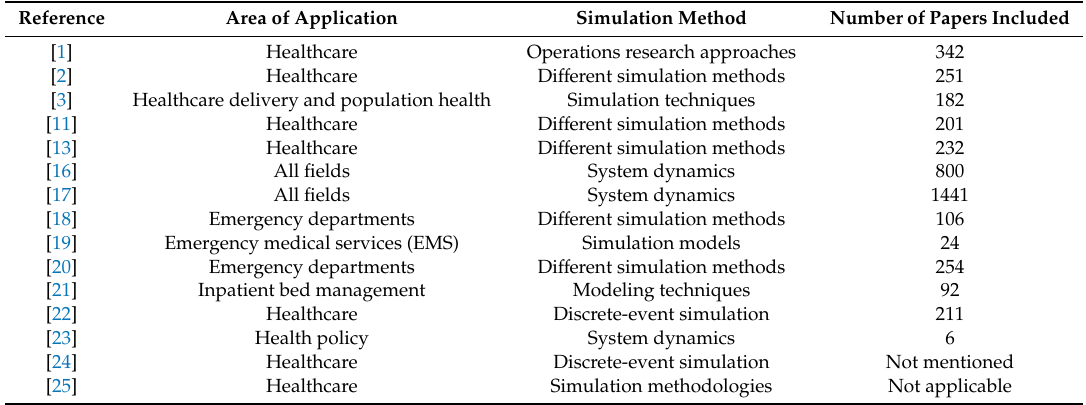
Table 1. Review articles related to simulation modeling in healthcare and published from 2000 to